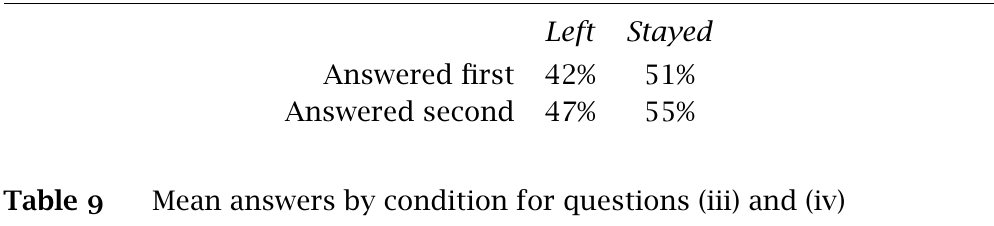
Left versus Stayed and Order